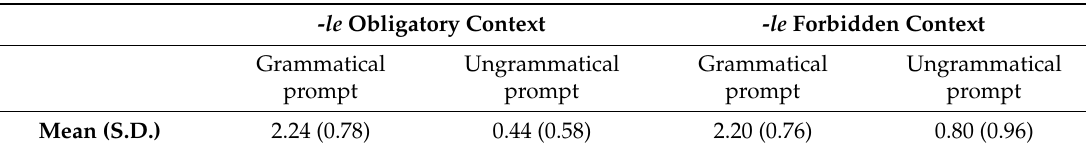
Table 3. Participants’ scores in grammaticality